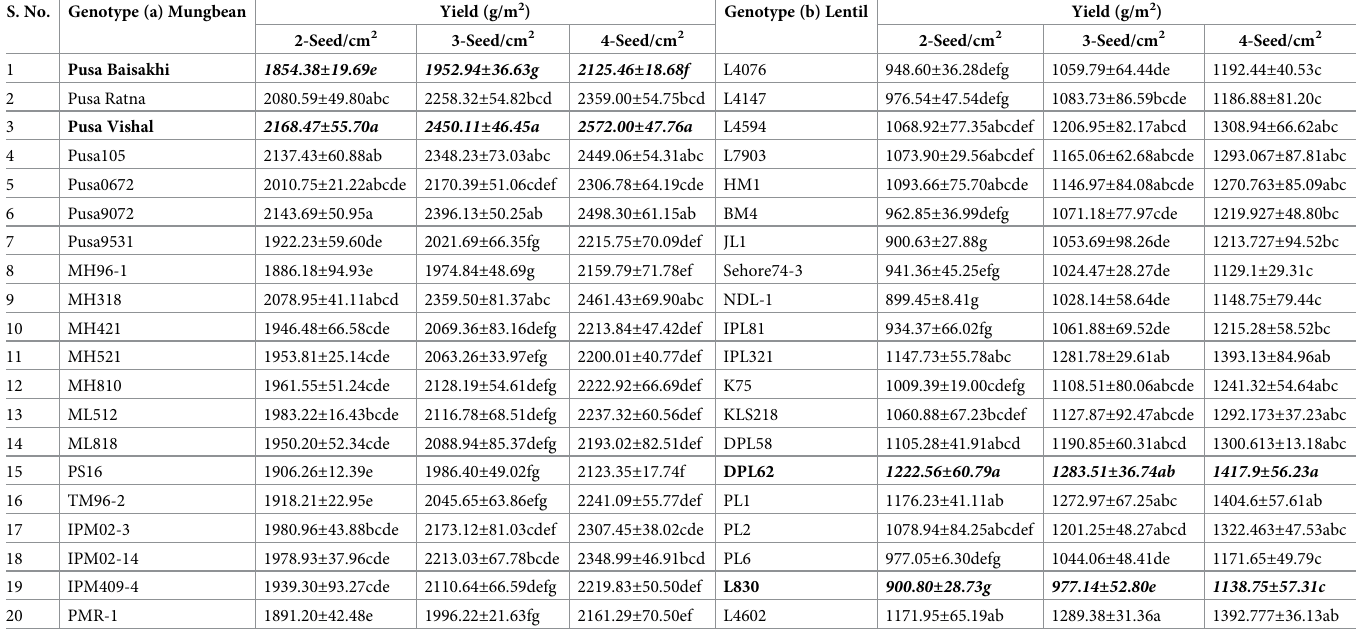
Table 2. Lentil and mungbean microgreens yield of twenty genotypes each at different seeding